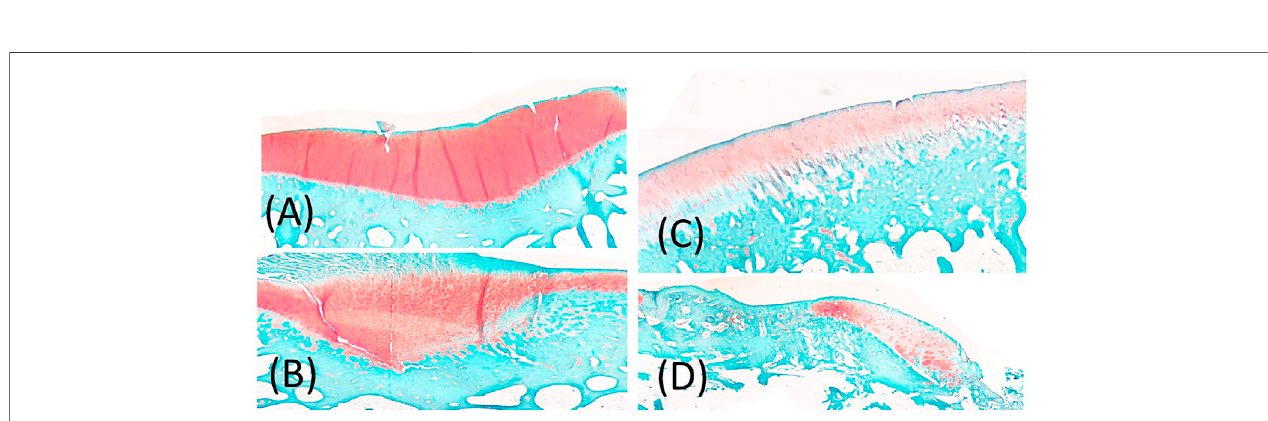
FIGURE 3 | Morphological scoring of cartilage. (A) intact cartilage with the surface appearing normal was assigned a score of 1, (B) a few surface lesions (red arrows) that retain ink was assigned a score of 2, (C) moderate fi brillation retaining intense black patches of ink (red circle) was assigned a score of 3, and (D) full thickness erosion exposing underlying bone (red circle) was assigned a score of 4.